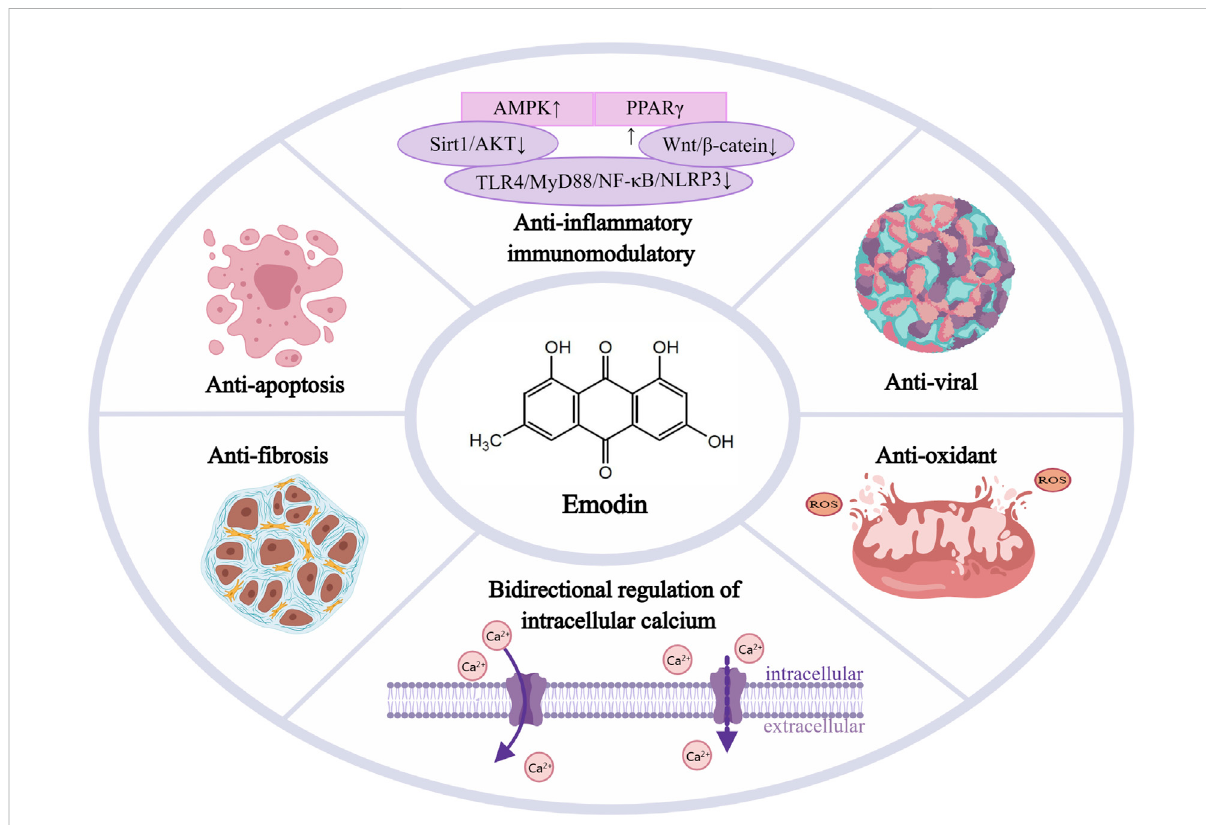
FIGURE 2 Emodin ’ s potent protective effects in cardiovascular diseases, Emodin has a series of protective effects in CVDs such as anti-in fl ammatory and immunomodulatory, anti-viral,anti-apoptosis, antioxidant and oxygen free radical scavenging, anti- fi brosis, and bidirectional regulation of intracellular calcium and L-type calcium electrodes in cardiac muscle. AMPK, activated protein kinase; PPAR γ , peroxisome proliferator-activated receptor γ ;Sirt1,sirtuin1; AKT, protein kinase B; TLR4,toll-like receptor-4; MyD88,myeloiddifferentiationfactor88; NF- κ B, nuclear factor kappa- B; NLRP3,Nod-like receptors